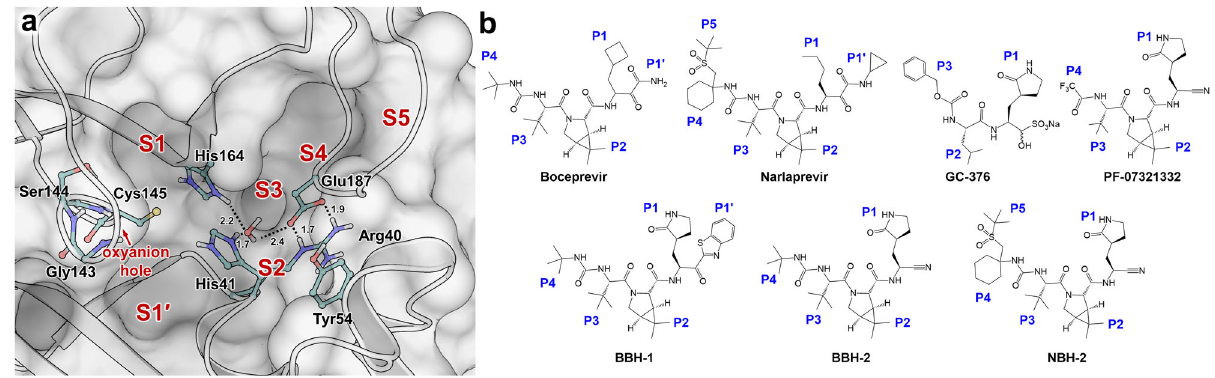
Fig. 1 Active site architecture of SARS-CoV-2 M pro and chemical structures of protease inhibitors. a Substrate binding subsites are indicated as S5-S1 ′ , including the oxyanion hole. b Reversible covalent inhibitors showing chemical groups P5-P1 ′ that bind in the subsites S5-S1 ′ ,